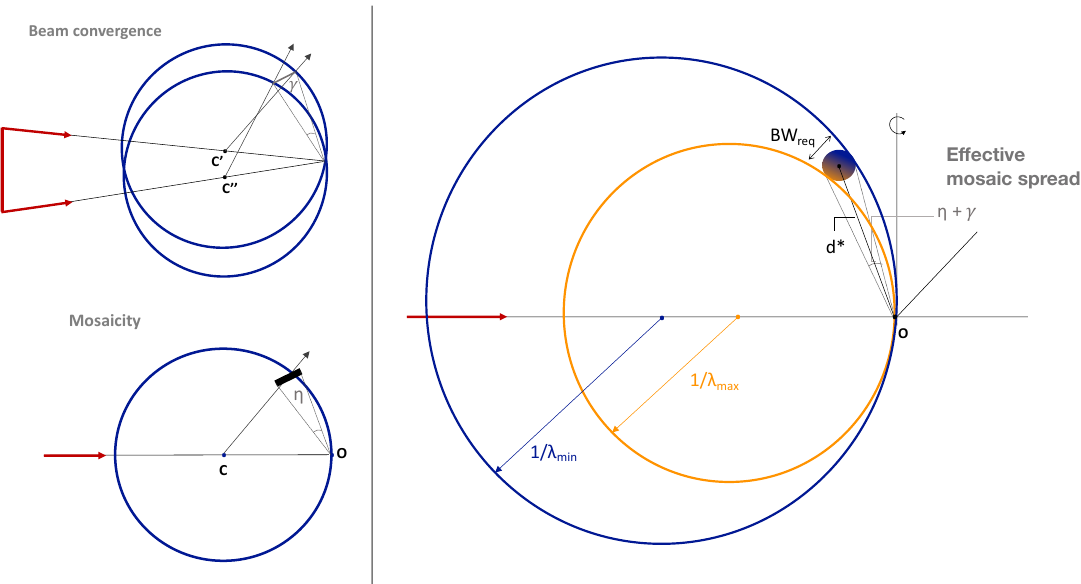
Figure 1. Effect of beam convergence ( γ ) and mosaicity ( η ) on the reflection bandwidth (BW req ). BW req depends on the sum of γ and η and on the distance of the reciprocal lattice point from the reciprocal space origin (d*). The minimum ( λ min ) and maximum ( λ max ) wavelengths of the spot bandwidth are shown together with the energy gradient across the